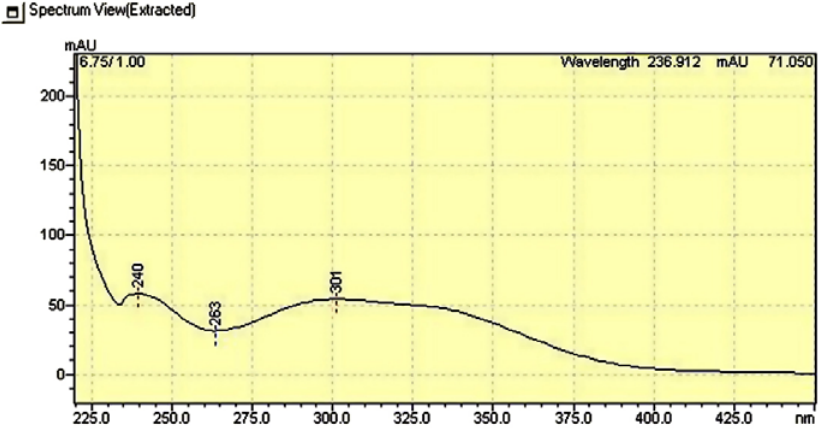
Figure 2. Absorption spectra of nimesulide (maxima at 240 nm and 301 nm)